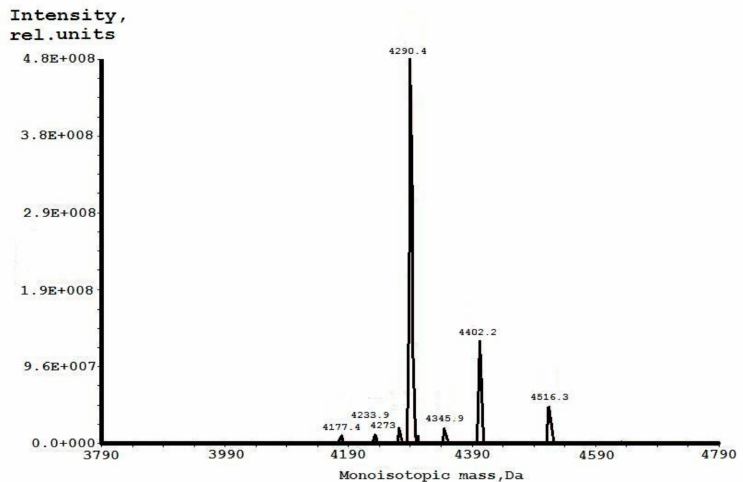
Figure 2. Analysis of the EcAMP1-Hyp.